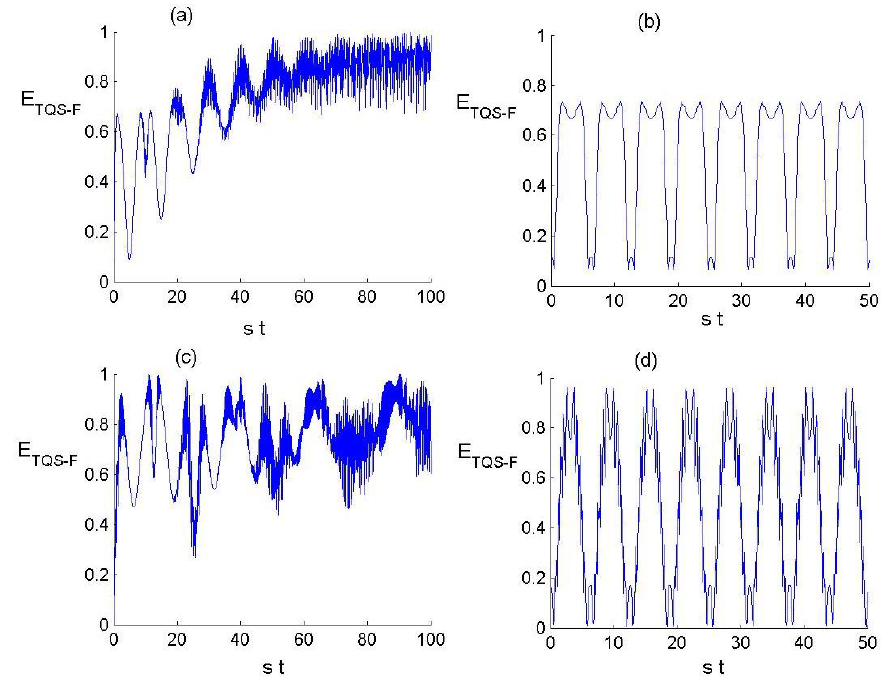
Figure 2. Time evolution of the QE of the TQS – field state denoted by 𝐸 TQS−F . Panels ( a , b ) correspond to the case of absence of the PDP effect (i.e., 𝜆 = 0) for constant (𝐷(t) = s) and t-dc ( 𝐷(t) = s sin(t)) , respectively. Panels ( c , d ) are, respectively, the same as ( a , b ) but in the presence of the PDP effect with 𝜆 = 50 .